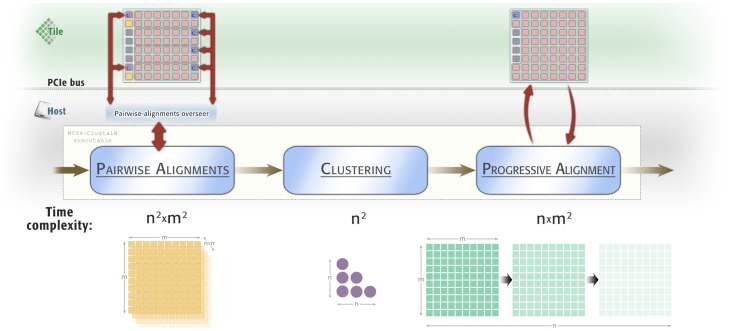
Heterogeneous programming model of the MC64-ClustalWP2 and each stage complexity.The executable algorithm is run in the host machine: the pairwise-alignments stage communicates with an external host program, which schedules the alignments among tiles. The clustering stage is executed in the host, and the progressive-alignment stage is controlled by the host, by calculating each profile alignment in the Tile64 microprocessor. The time complexity of each stage is shown in the lower part.